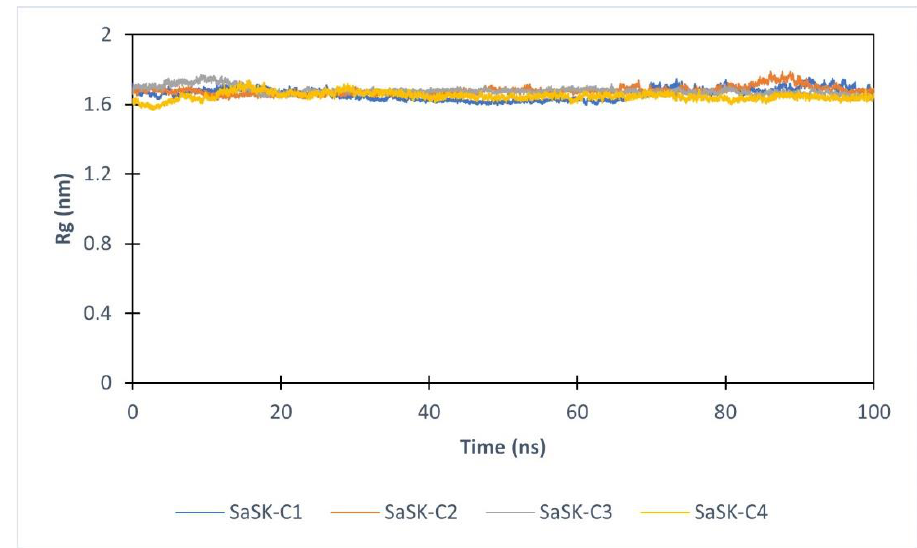
Figure 5. Radius of gyration for SaSK in complex with C1(Blue), C2 (Orange), C3 (Gray), C4 (Yellow). Finally, hydrogen bond analysis was performed. The data show that the number of H-bonds in the complexes vary during simulation time with an average of 7, 4, 3, and 1 for SaSK- C1 , SaSK- C2 , SaSK- C3 , and SaSK- C4 , respectively, suggesting a better binding mode for compound C1 (Figure 6 and Table 2).